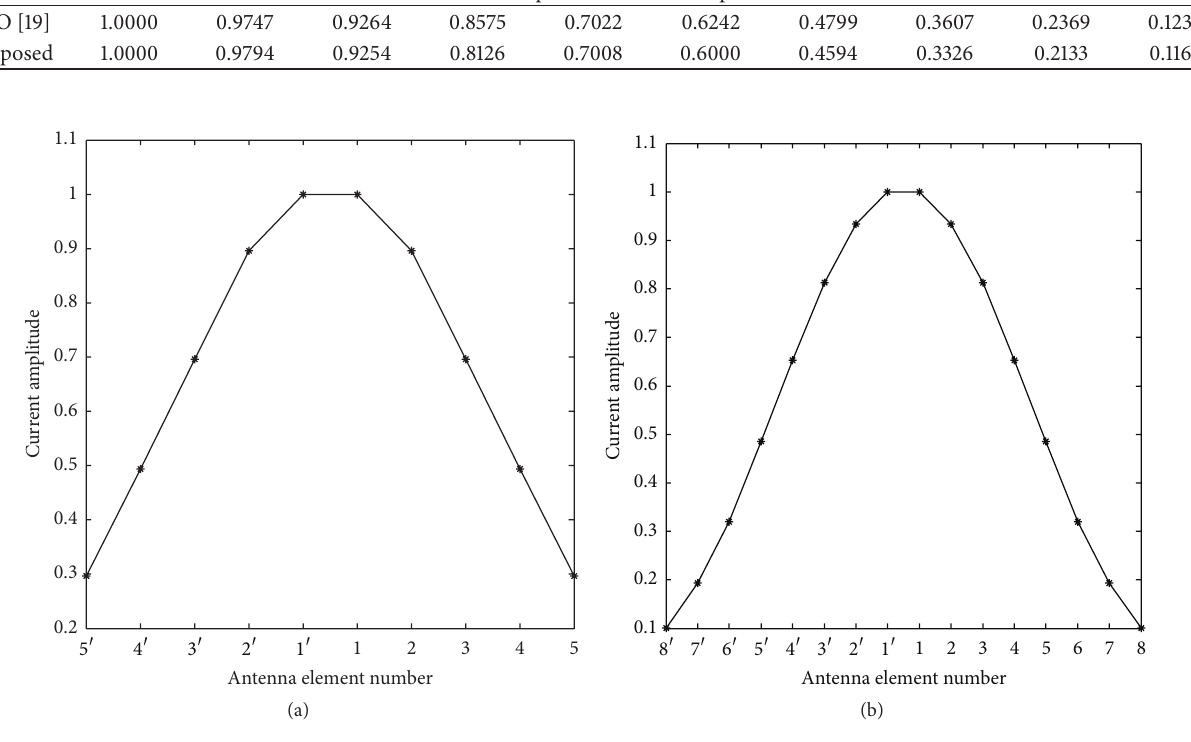
Figure 9: Current distribution for (a) Example 5 and (b) Example 6.